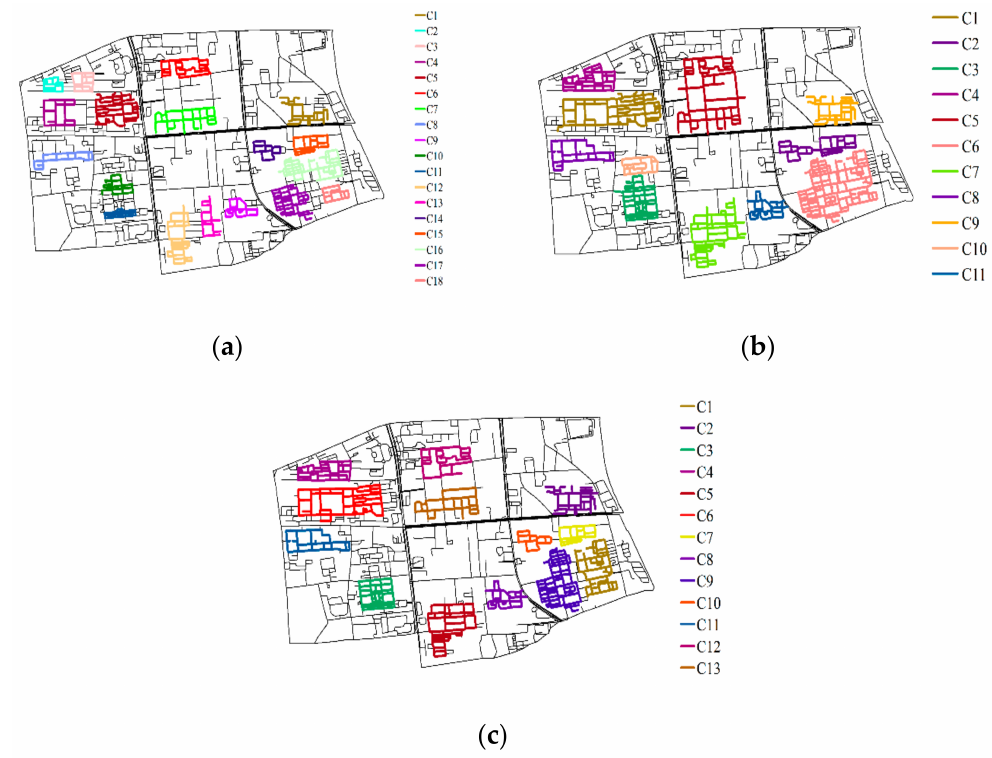
Figure 4. Communities identified by EACO: ( a ) snapshot 1; ( b ) snapshot 2; ( c ) snapshot 3.